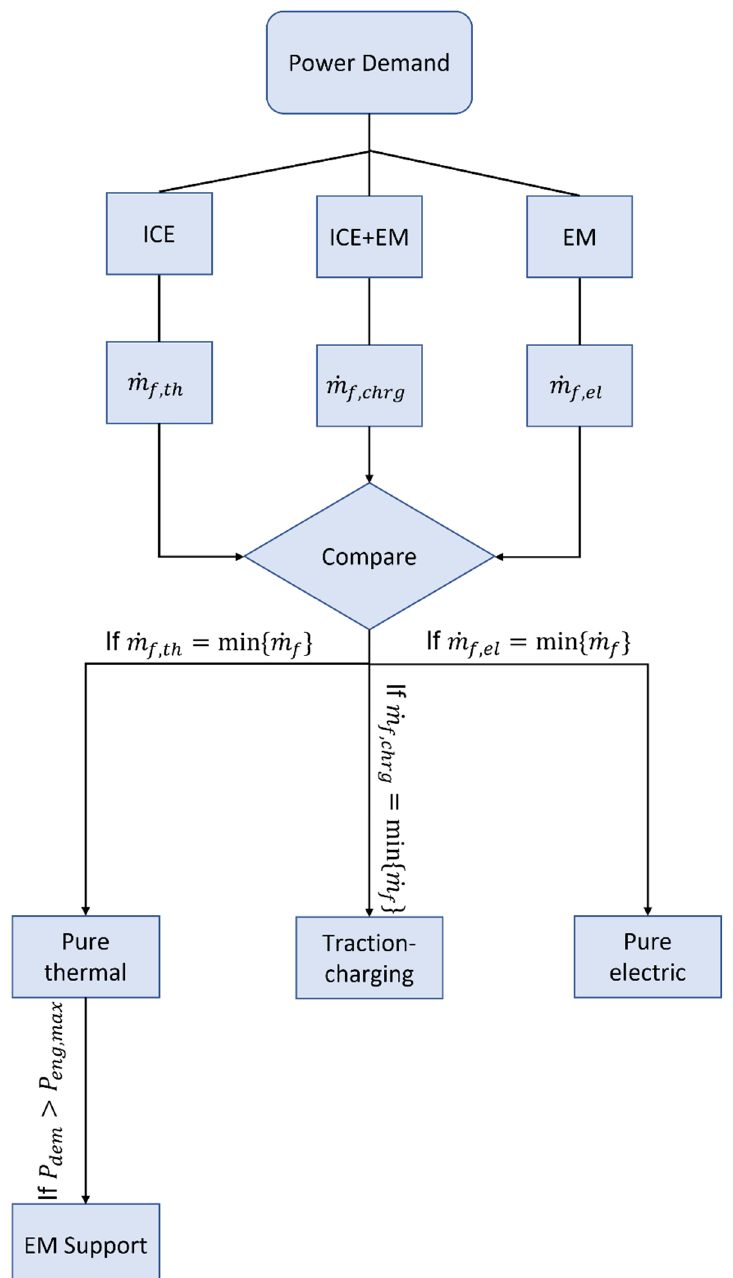
Figure 5. Flowchart that schematizes the ETESS logic.